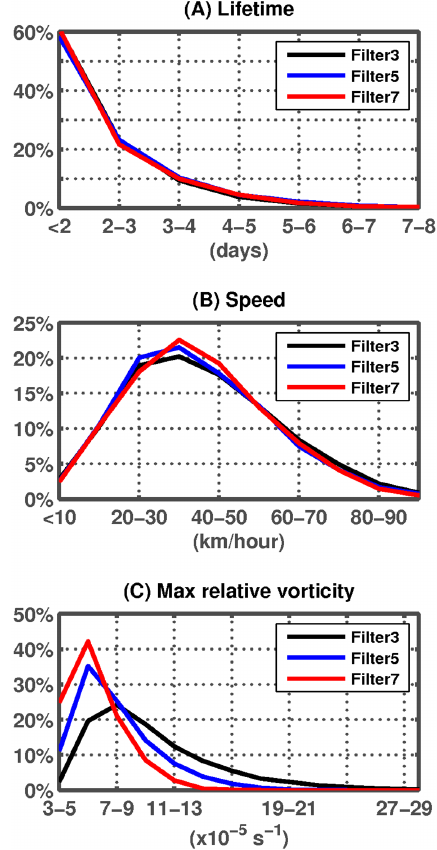
Figure 7. (a) Relative frequency distributions of cyclones lifetimes for the three sensitivity tests. (b) As in (a) but for cyclones average speed. (c) As in (a) but for tracks’ maximum relative